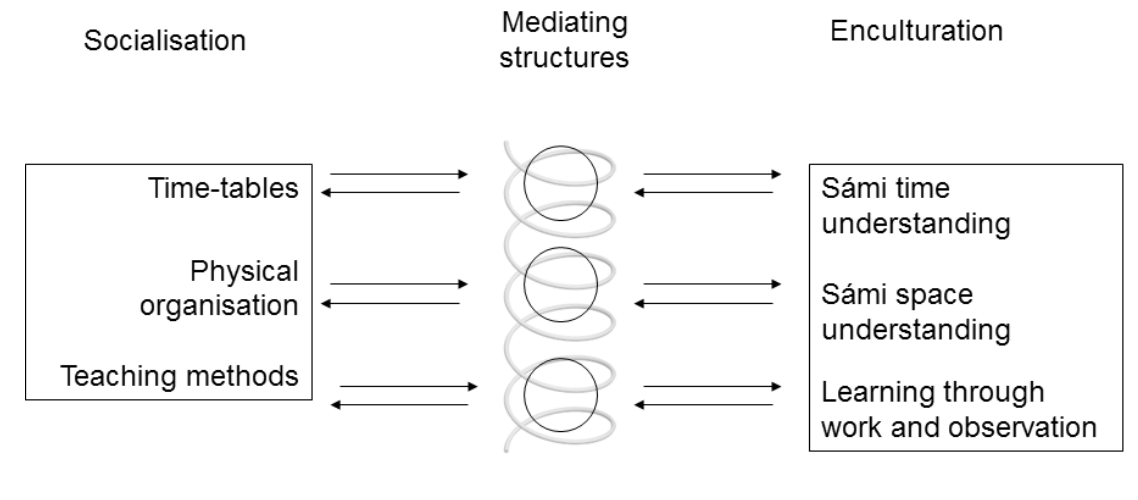
FIGURE 1 The mediating structures of Sámi